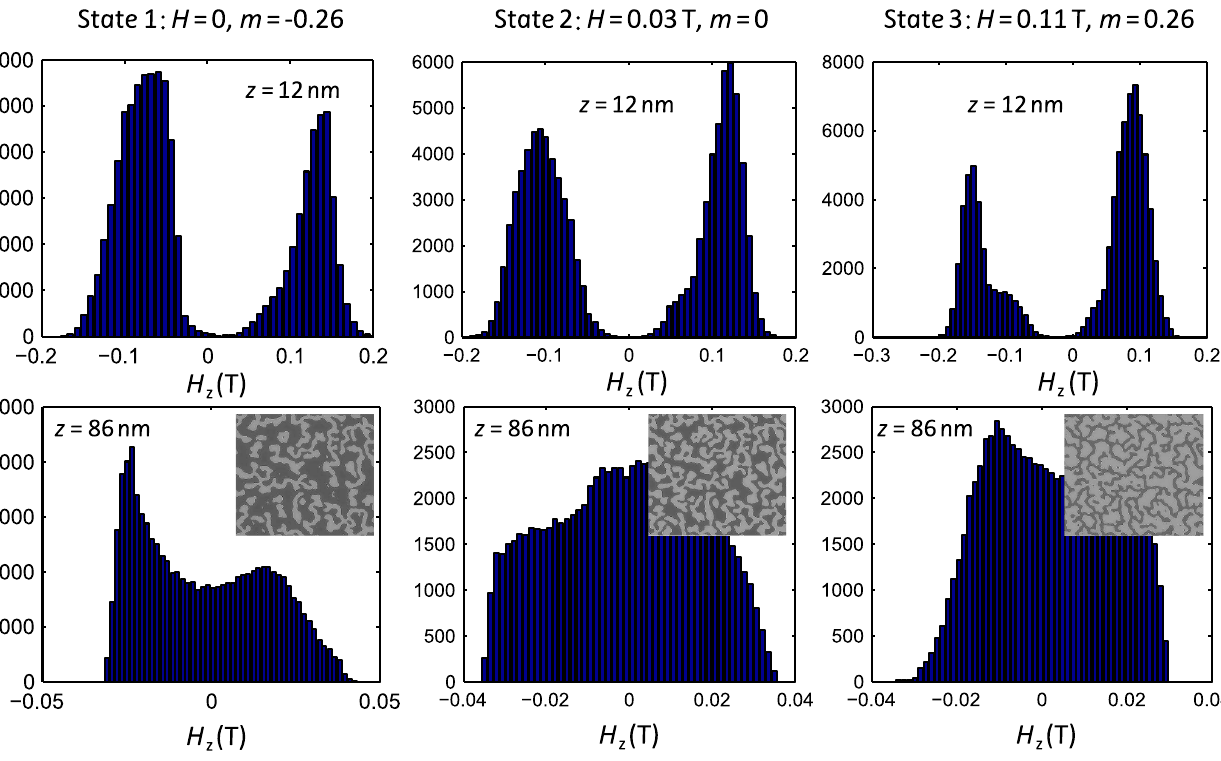
FIG. 14. Histograms (probability distribution) of the fringe fields in the z direction H shown; the values for H and m are approximate. The histograms correspond to magnetic fields at (row 1) 12 nm and (row 2) 86 nm from the ferromagnetic electrode, respectively. The grey insets are XMCD images of the magnetic domain structure which are 3 (cid:1) 3 (cid:1) m 2